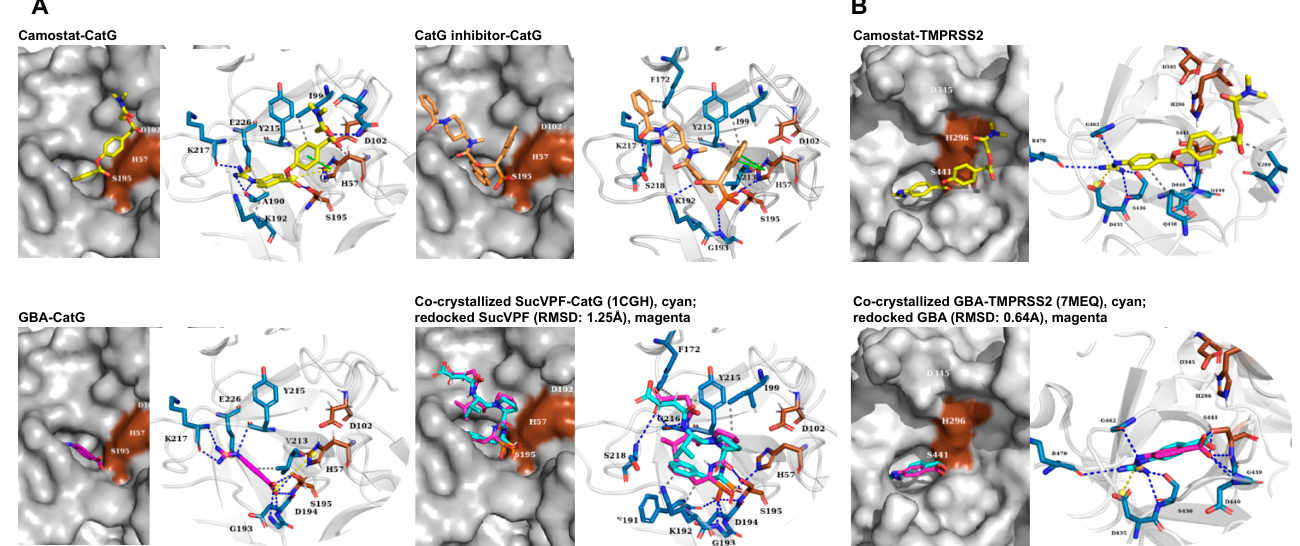
Figure 3. Binding processes of serine protease inhibitors to CatG and TMPRSS2 by using AutoDock4. ( A ) The catalytic center containing the catalytic triad is tinted brown within the surface model of CatG (grey). Interaction of camostat (yellow), GBA (pink), CatG inhibitor (orange), and SucVPF (green) with CatG. Redocking the co-crystalized SucVPF-CatG (1CGH) complex and SucVPF was performed to validate the docking protocol. ( B ) Prediction of TMPRSS2 complexed with camostat. Co-crystallized GBA-TMPRSS2 (7MEQ) and redocking with GBA were attributed for validation. The crystal structures of the complexes were analyzed using the protein-ligand interaction profiler (PLIP). The dashed lines correspond to the molecular interactions formed between the inhibitor and the indicated amino acids of CatG or TMPRSS2. Dashed lines in blue, hydrogen bonds; grey, hydrophobic; yellow, salt bridges; green, pi-stacking interactions.